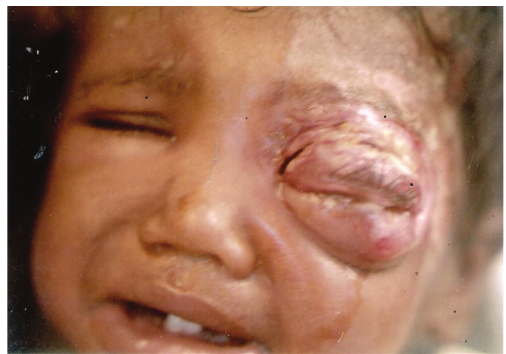
Figure 4: Post treatment photograph of same